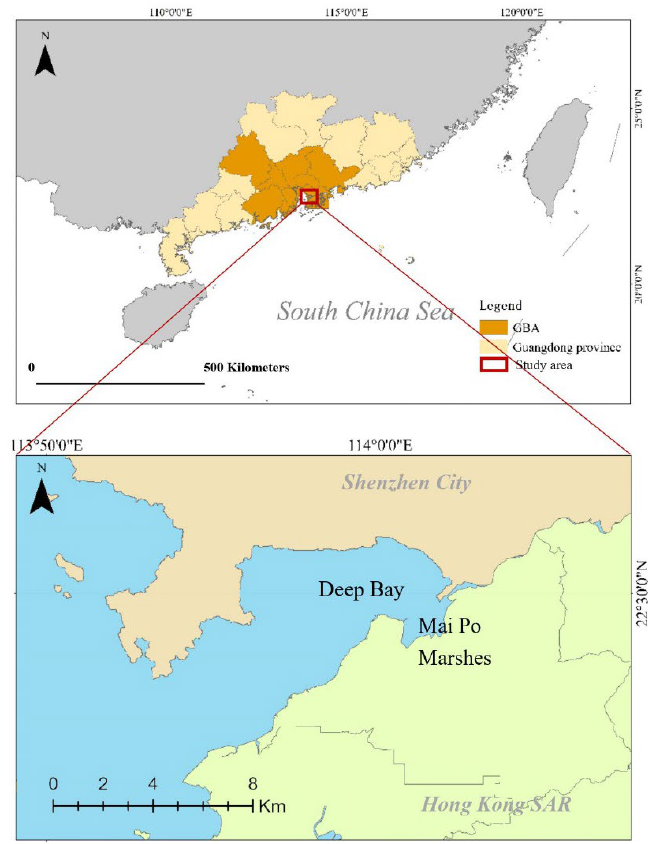
Figure 1. A map of the study area illustrating the local environment of Deep Bay and its position as part of the Greater Bay Area (GBA), supporting a population of 70 million. The lower diagram indicates the area analyzed in this study. This map was made on Universal Transverse Mercator (UTM) projection and World Geodetic System-84 (WGS-84) datum.